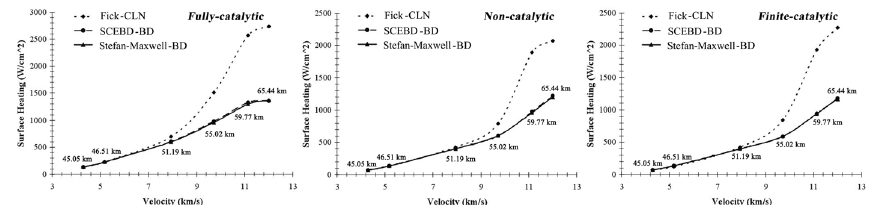
Fig. 11 Heat transfer at the stagnation point of a sphere with different diffusion models [99]